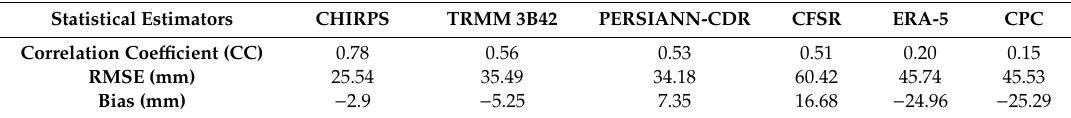
Table 6. Summary of statistical monthly average result over the study area. Statistical